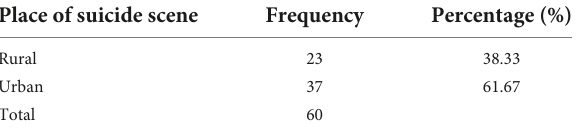
TABLE 1 Place of suicide scene.